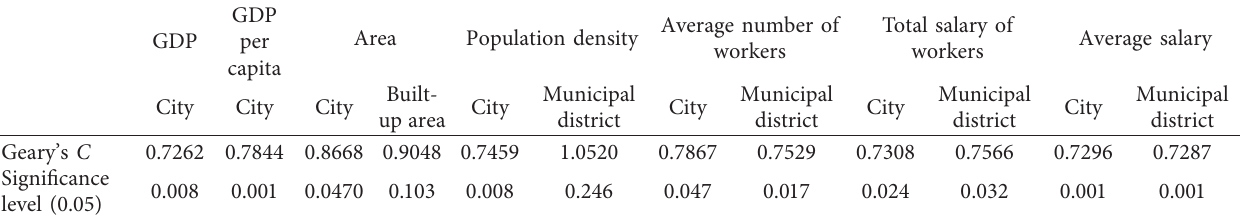
Table 1: Results of the global spatial autocorrelation analysis of four provinces and one city in the lower reaches of the Yangtze